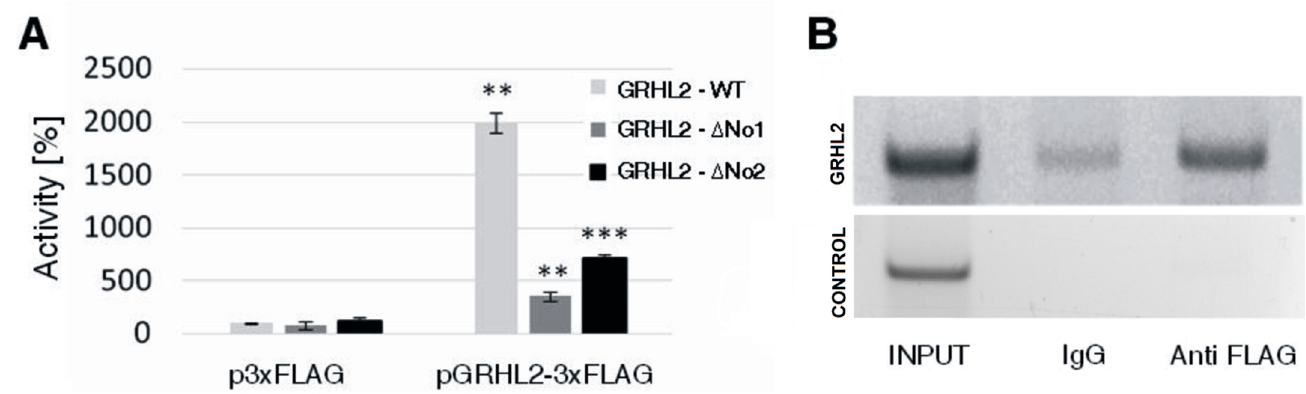
Figure 3. Influence of GRHL2 on S100A10 expression and its binding to the S100A10 intronic sequence. ( A ) Luciferase assay with plasmids containing the S100A10 intronic sequence wild-type (GRHL2-WT) or lacking one of the GRHL2 binding sites (GRHL2- ∆ No1 or GRHL2- ∆ No2). Statistical analysis of results obtained from n = 3 experiments was performed with the use of Student’s t -test. Results are presented as means ± standard deviation. The level of statistical significance is indicated using ** p ≤ 0.01 or *** p ≤ 0.001. ( B ) A representative ChIP result—PCR products obtained with the use of primers encompassing both potential GRHL2 binding sites (upper panel) and primers that amplify a region of DNA not predicted to bind GRHL2 (lower panel).